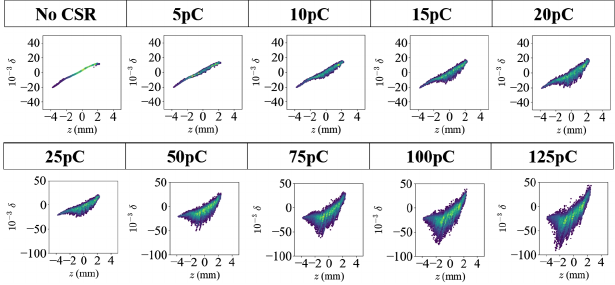
24. The orbits of the four design energies inside the first half of the FFA beamline, including FA, TA, and ZA. The second half (not included) has approximately mirrored orbits and